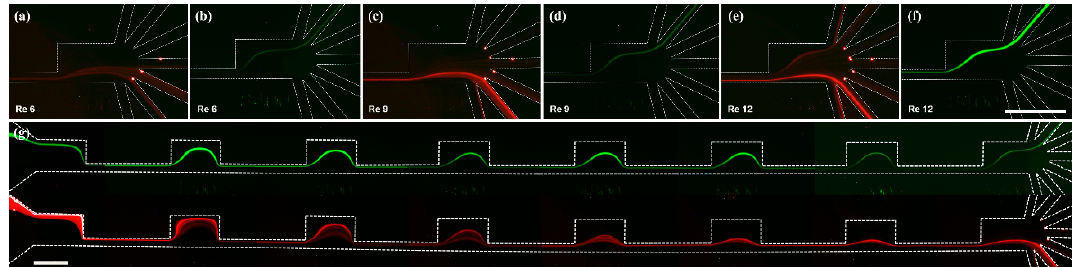
Figure 3. Trajectories of 6 µ m (red) and 20 µ m (green) fluorescent beads at the outlet of the CEA microchannel with Re of 6 ( a , b ), 9 ( c , d ), and 12 ( e , f ). Fluorescent microscope images of 6 µ m (red) and 20 µ m (green) fluorescent beads throughout the CEA microchannel at Re of 9 ( g ). Scale bar = 500 µ